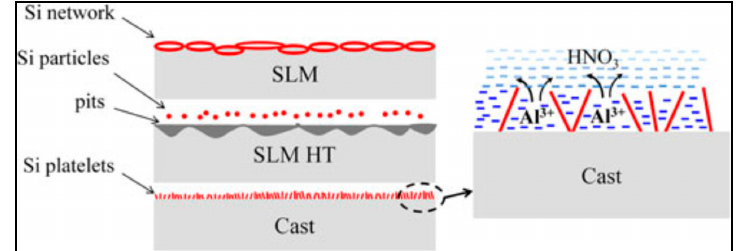
Figure 14. Schematic illustrations showing the corrosion behavior in Al–12Si as-prepared SLM, heat-treated SLM, and the cast samples under acidic environment. Reprinted with permission of [75].